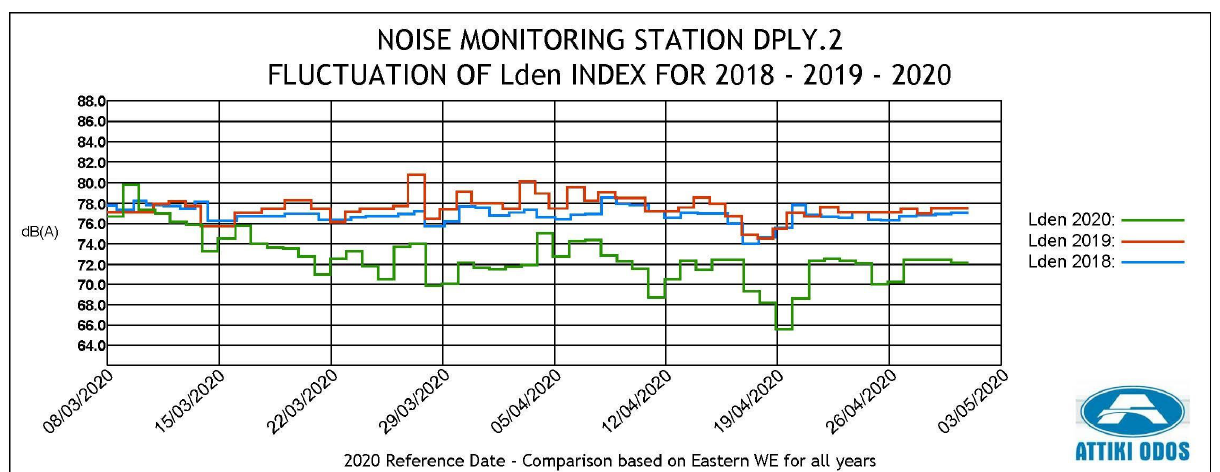
Figure 9h: Fluctuation of L den index – Noise monitoring station